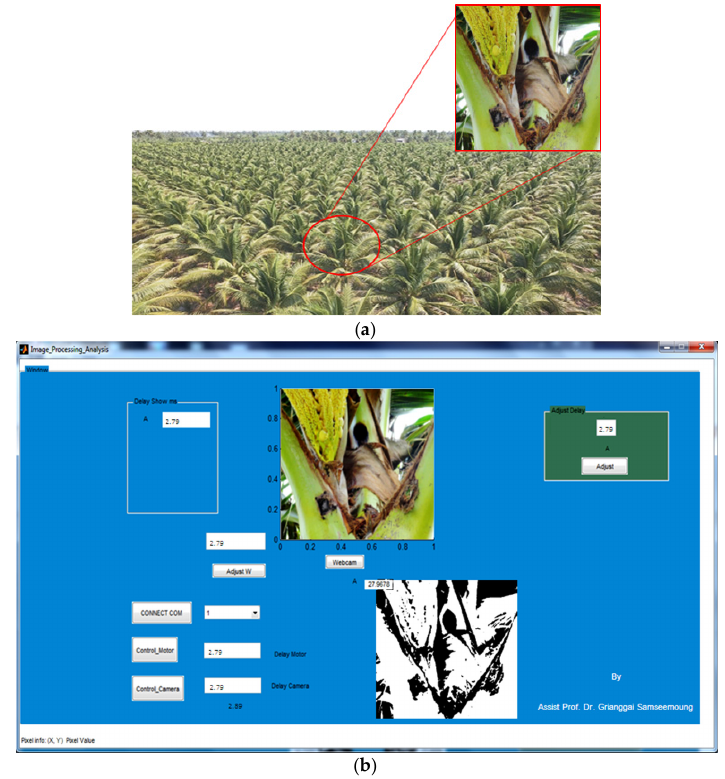
Figure 5. Image from the remote monitoring system; ( a ) coconut pest disease infestation, ( b ) image data processing (segmentation).